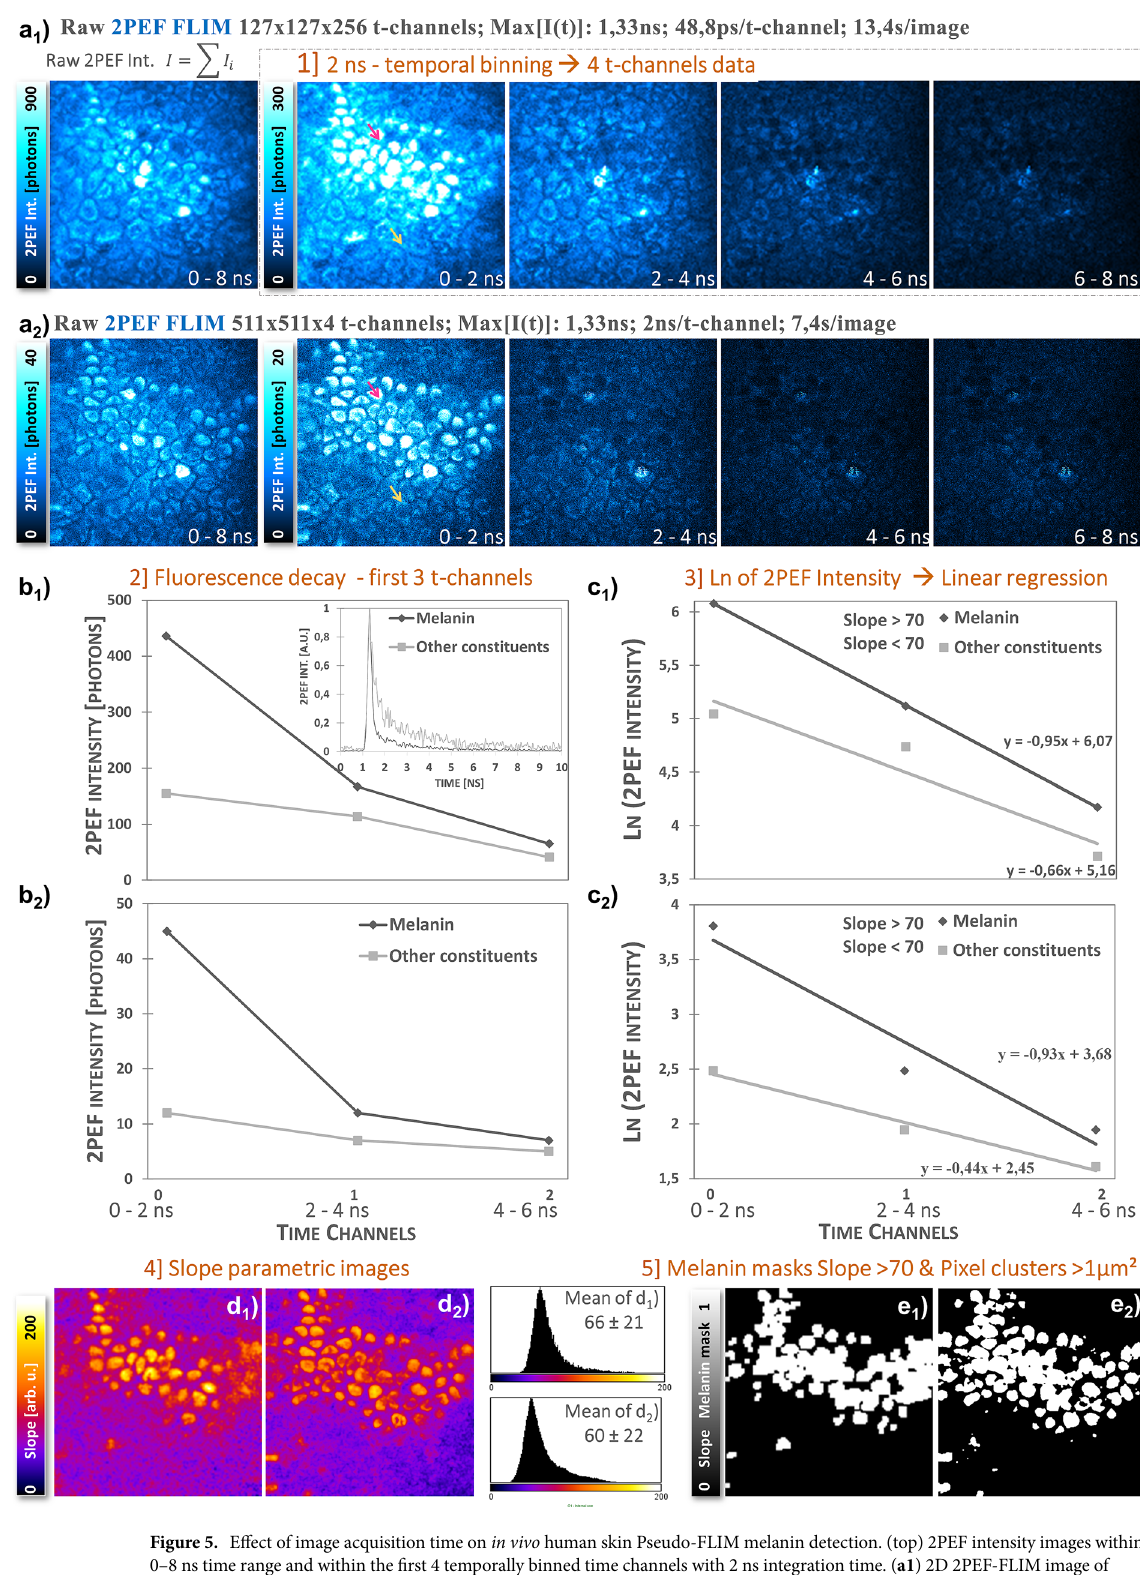
Figure 5. Effect of image acquisition time on in vivo human skin Pseudo-FLIM melanin detection. (top) 2PEF intensity images within 0–8 ns time range and within the first 4 temporally binned time channels with 2 ns integration time. ( a1 ) 2D 2PEF-FLIM image of 127 × 127 pixels × 256 time channels acquired within the basal layer of the epidermis (104 µs pixel dwell time); ( a2 ) 2D 2PEF-FLIM image of 511 × 511 pixels × 4 time channels extracted from a z-stack and acquired almost within the same 2D plane at 28 µs pixel dwell time. ( b1 , b2 ) shows the corresponding 2PEF intensity decays of the first 3 temporally binned channels for a high slope (red arrow, melanin) and small slope (yellow arrow, other constituents) pixels. The full decay of these two pixels extracted from the 256 t-channels images is given in the insert in graph ( b1 ). Graphs ( c1 , c2 ) show the natural logarithm transformation and linear regression fitting to extract the slopes of the decays. Images ( d1 , d2 ) show the corresponding slope parametric images and their Pseudo-FLIM melanin mask is given in images ( e1 , e2